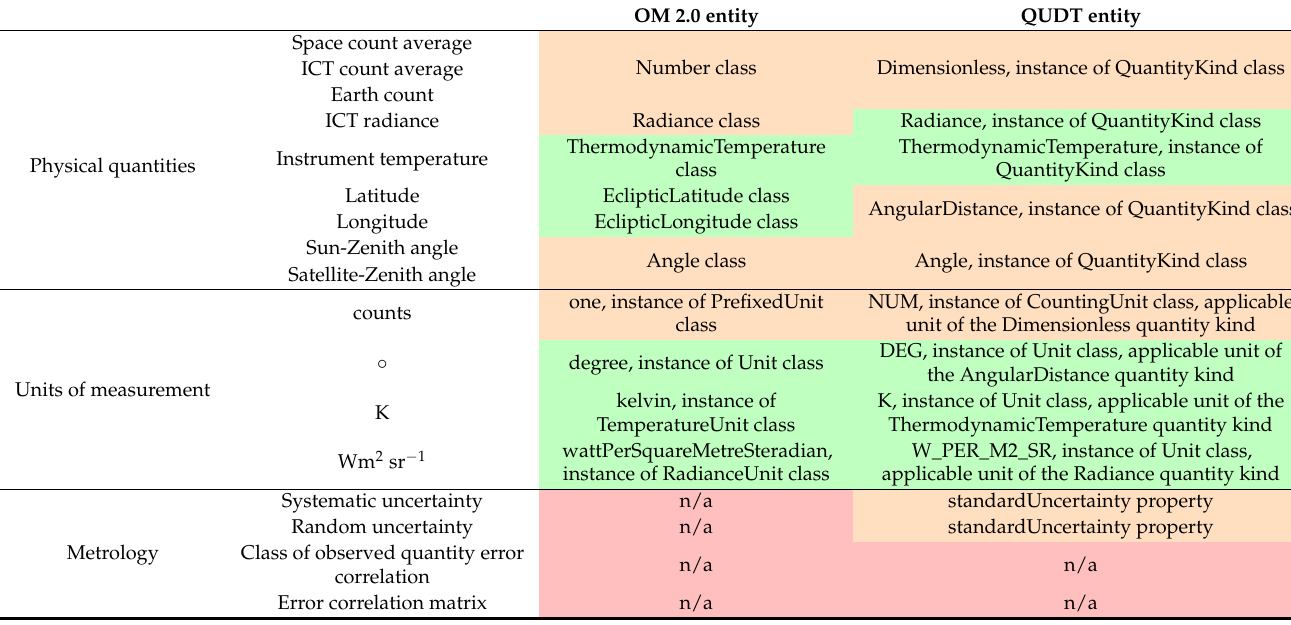
Table 1. Summary of metrology-relevant features implemented for the satellite case study using OM 2.0 and QUDT. Colour denotes how well a concept is defined in the ontology (green: fully, amber: partially, red: